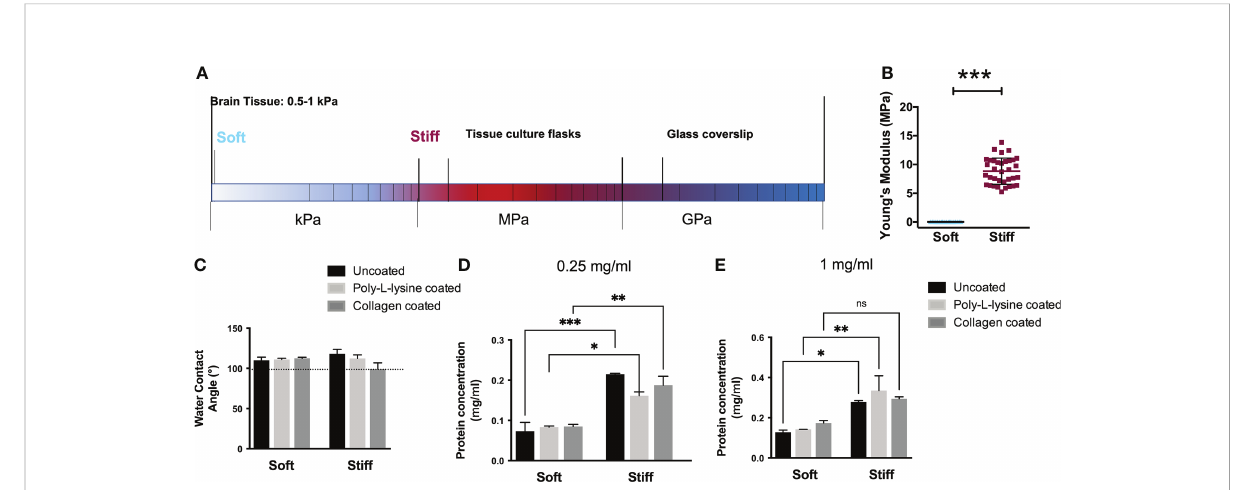
FIGURE 1 Characterization of the surface properties of the substrates ranging from soft to stiff. (A) Schematization of the Young ’ s modulus compared with the elasticity of brain tissue. (B) Elastic modulus of the substrates (n = 3 samples for each stiffness) in the range from few kPa to ~12 MPa. Student T test, ***p<0.001. (C) Water contact angle of uncoated and protein coated (poly-L-lysine and collagen I) substrates. The water contact angles of the uncoated substrates (black) are approximately 110°, indicating a similar surface energy and hydrophobicity. The water contact angles of protein coated substrates showed comparable values, indicative of similar protein adsorption behavior and surface energy. (D-E) Protein concentration (mg/mL) determined on uncoated and protein coated (poly-L-lysine and collagen I) Soft and Stiff substrates for different BSA protein concentration: 0,25mg/ml (D) 1mg/ml (E) . Data presented as mean ± S.D., n = 3 independent experiments for each condition. One- way ANOVA followed by Holm-Sidak post-hoc analysis; *p<0.05, **p<0.01, ***p<0.001. ns = not signi fi